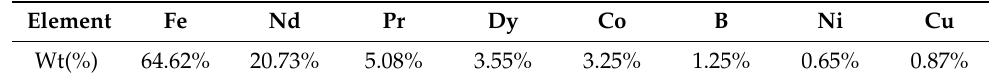
Table 2. The composition of waste neodymium magnets.